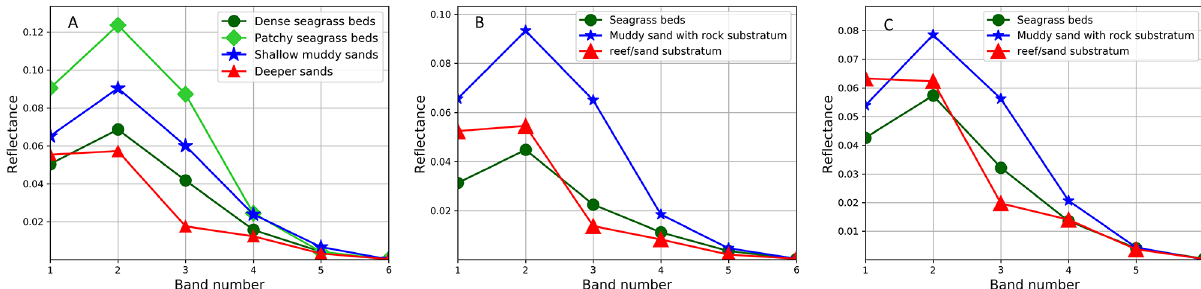
Fig. 5. Spectral re fl ectance pro fi les of different substrata at TL, XT and MG in different bands. A =TL, BXT and C= MG. See Figure 1 for the abbreviation of locations.